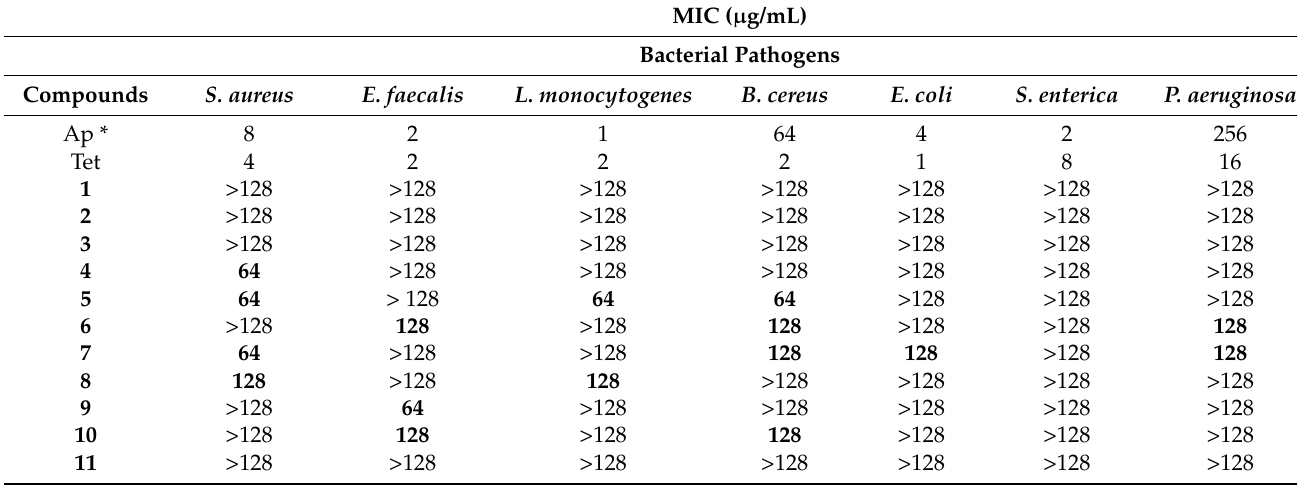
Table 4. The minimum inhibitory concentration (MIC) value of isolated compounds and antibiotics for different bacterial